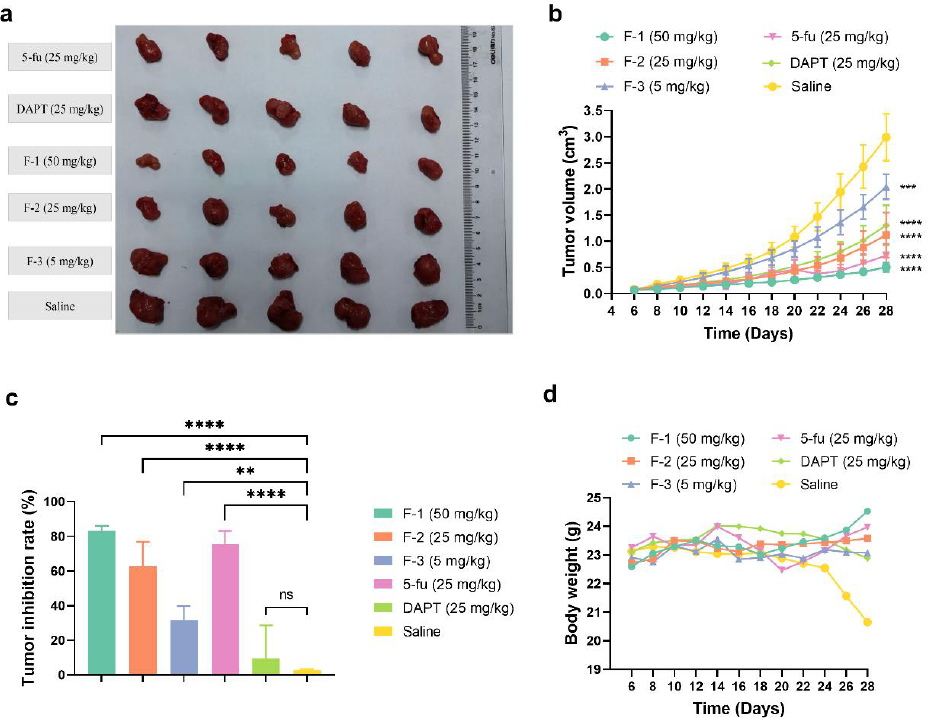
Figure 9. The in vivo antitumor effects of fidaxomicin in 4T1 tumor-bearing mice. ( a ) The photograph of tumors excised from sacrificed mice. ( b ) Tumor growth curve, ( c ) tumor inhibition rate, and ( d ) body weight profile were demonstrated after different treatments. Data shown represent the mean ± SD ( n = 5, ** p < 0.01, *** p < 0.001, and **** p < 0.0001 vs. control group, ns: no significance).